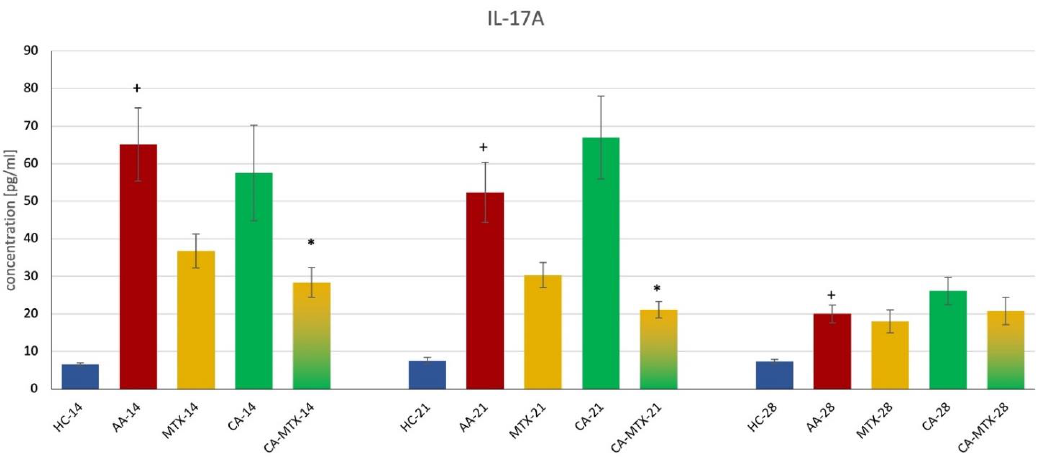
Figure 3. Interleukin 17A (IL-17A) levels in plasma on 14th, 21st, and 28th day. + HC vs. AA, * AA vs. MTX/CA/CA-MTX, p ≤ 0.05.